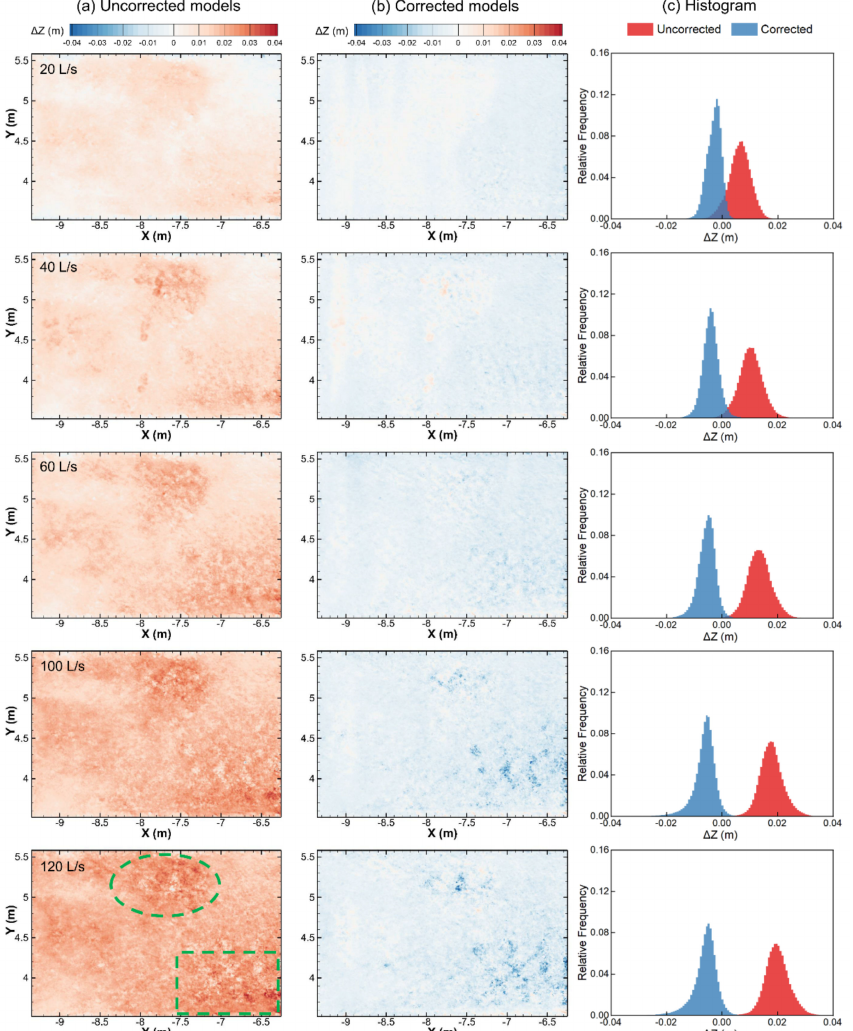
Figure 7. The contours and histograms of elevation errors for the through-water SfM models using the bank GCPs for MR2: ( a ) uncorrected models; ( b ) corrected models; ( c ) histograms. Flow goes from the left to the right. The two relatively low areas are marked by green dashed lines in ( a ) at Q = 120